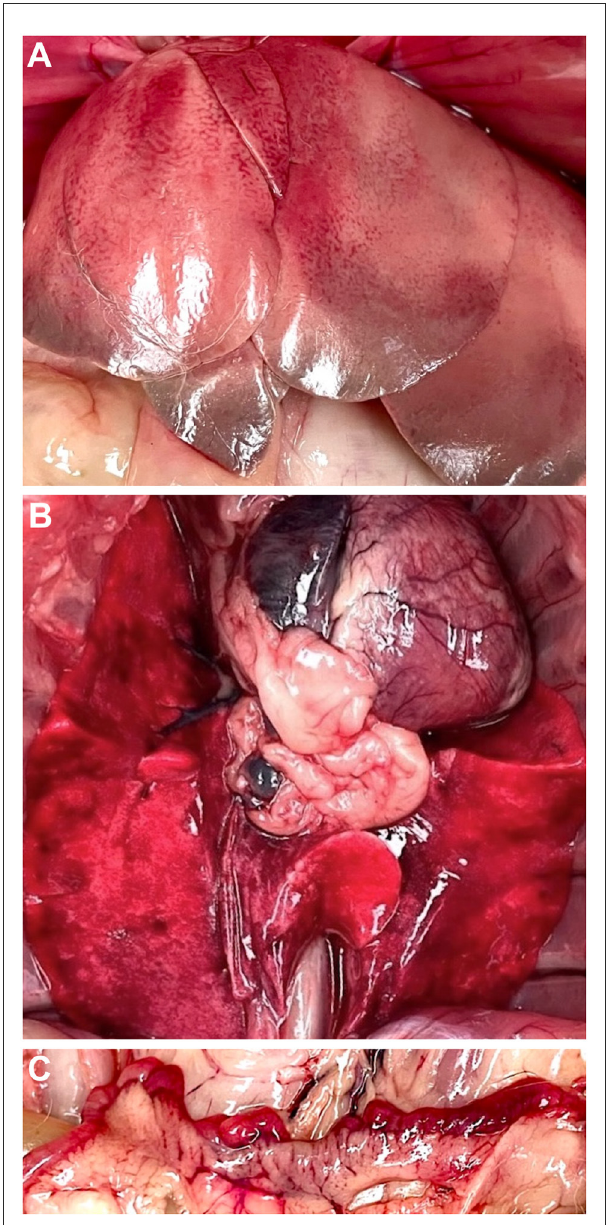
FIGURE1 Necropsy findings in rabbit #4 ( Oryctolagus cuniculus cuniculus ) case. Liver with an enlarged, pale, and distinct lobular pattern with light gray discoloration in the edges of the lobes (likely a postmortem change) (A) . Lungs (B) and uterus (C) had multifocal to coalescing